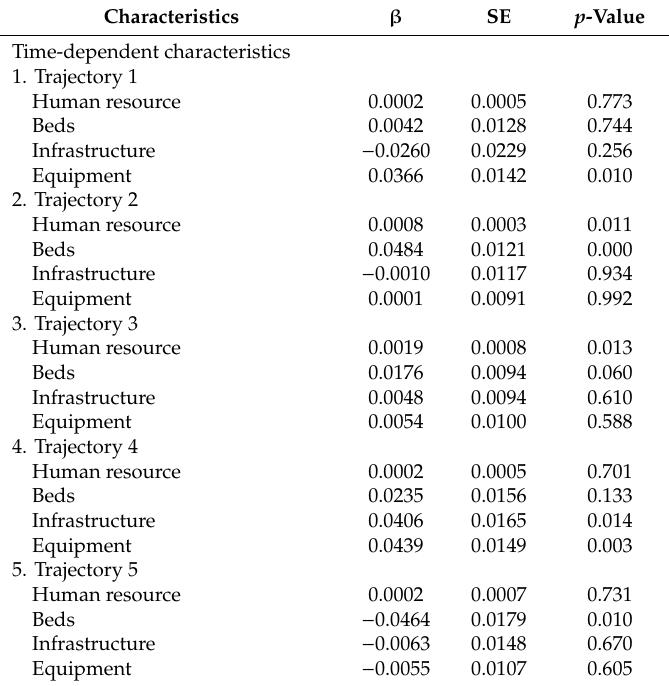
Table 7. Time-dependent characteristics associated with di ff erent trajectories of basic public health services ( n =